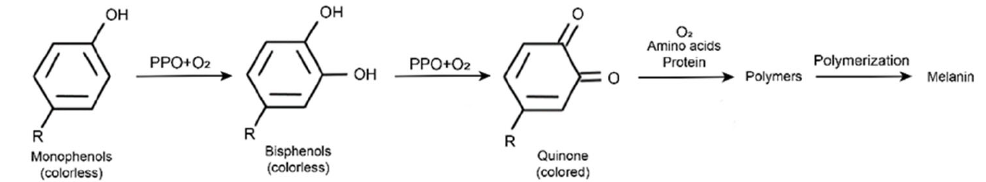
Figure 1. PPO catalyzes monophenol hydroxylated to o -diphenol and catalyzes o -diphenol to o -quinone. Then, o -quinone further polymerizes and condenses with amino acids and proteins to produce brown substances.